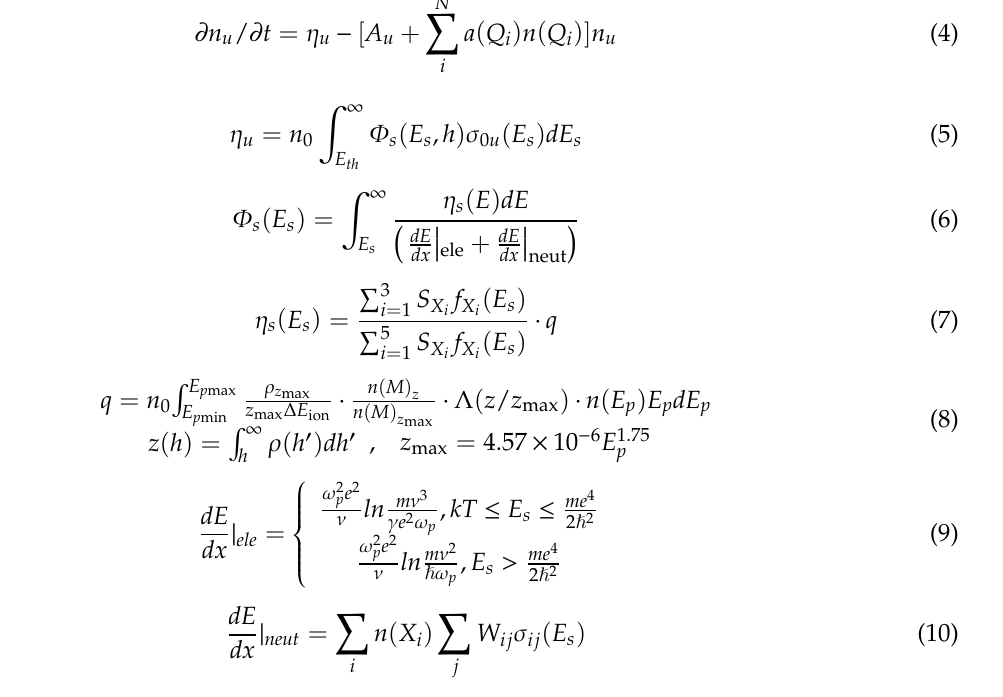
Table 1. Units for physical